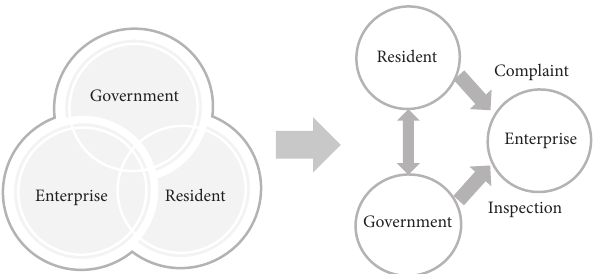
Figure 5: The transformation of the relationship among multiplayer with governmental